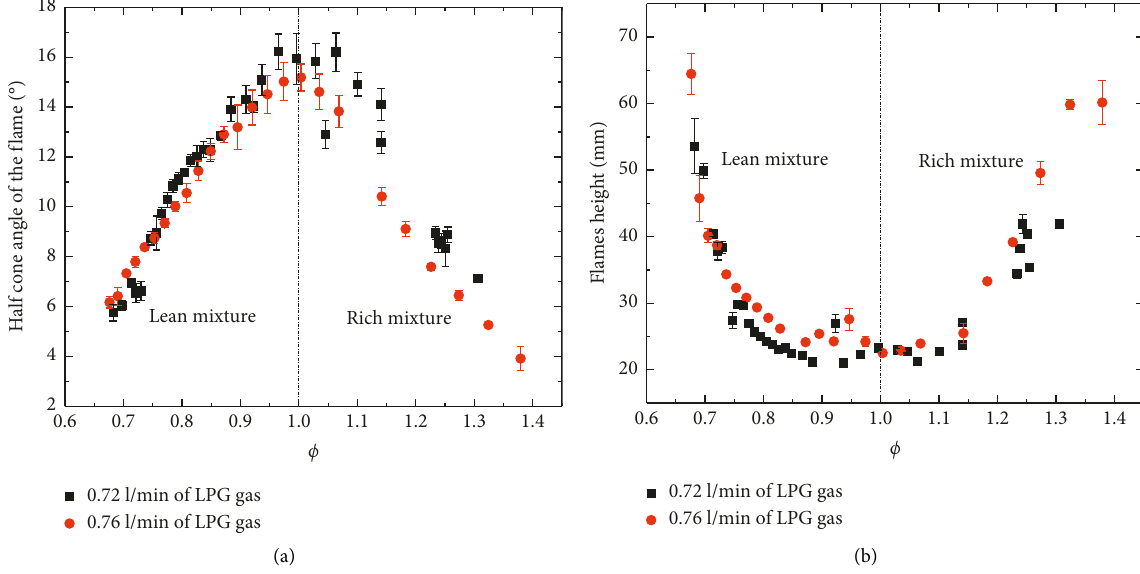
Figure 7: Half-cone angle of the flame measurements (a) and flame height (b) for different equivalence ratios at different Saudi LPG flow rates: ( ■ black solid square) for 0.72l/min and ( ● red solid circle) for 0.76l/min LPG flow rates using the modified Bunsen burner.